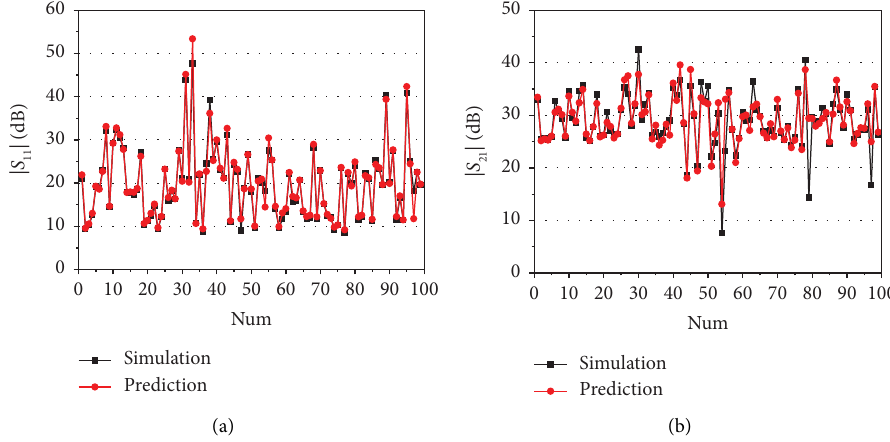
11 |. (b) Isolation | S 21 |.